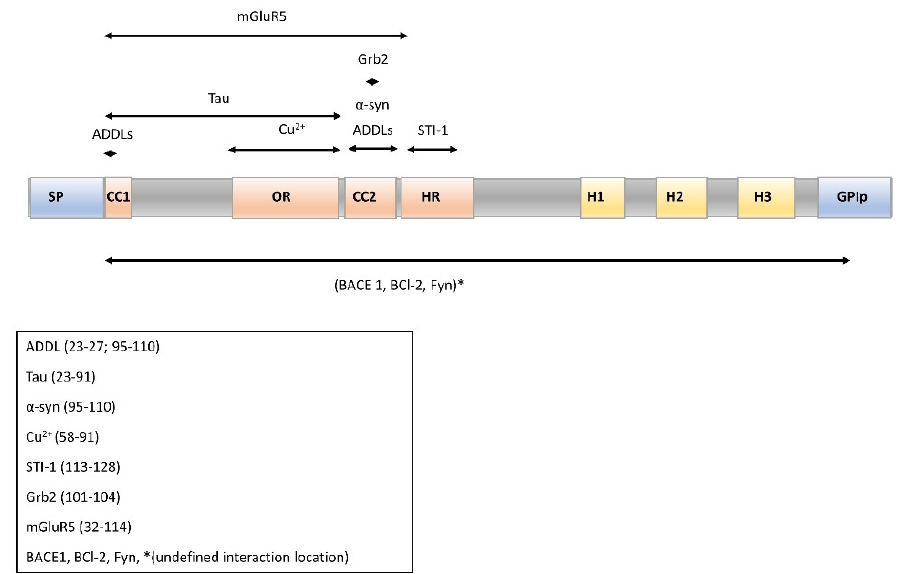
Figure 2. Schema of the PrP C sequence with its different domains showing the interaction of molecules described in this article. SP: signal peptide 1–22 aa; CC1: charged cluster 1,23–30 aa; OR: octarepeat region 60–91 aa; CC2: charged cluster 2, 95–110 aa; HR: hydrophobic region 112–133 aa; H1-3: α -Helix regions 143–452, 171–191, 199–221; GPIp: GPI anchor-signaling peptide. (Numbering based on the moPrP sequence.)